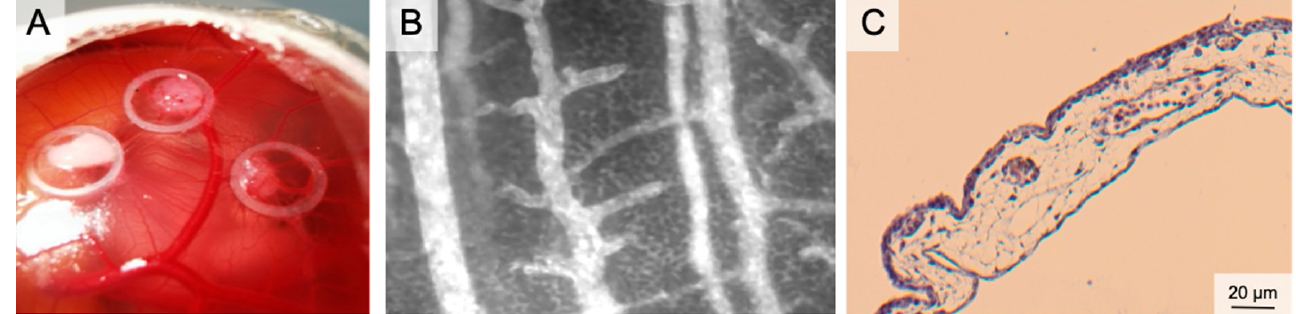
Figure 3. The Chorion Allantois Membrane Assay. ( A ) Representative macroscopic image of the CAM vessels after implantation of squamous cell carcinoma cells. The tumors grow within silicone rings. ( B ) Intravital microscopy following iv FITC-dextran injection. The image depicts venules and arterioles surrounded by the dense capillary network. ( C ) HE staining of the CAM membrane showing well-vascularized connective tissue between the low epithelial layers. Plenty of in ovo- and ex ovo-preparations have been described to access the